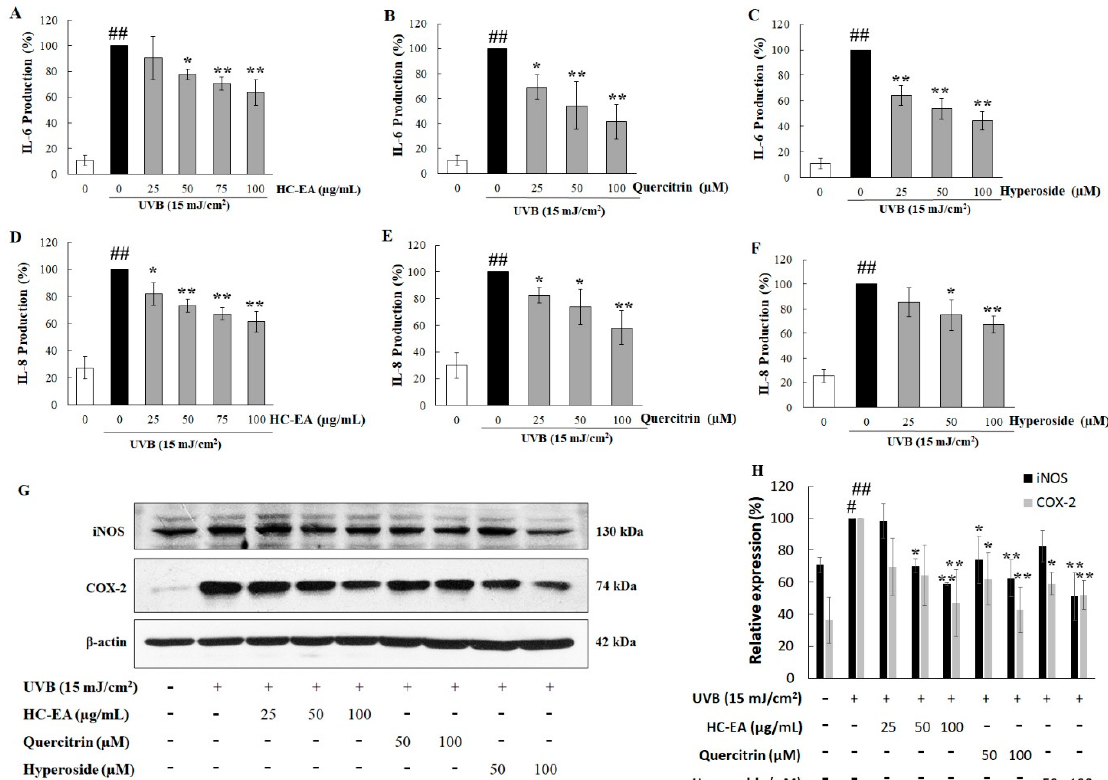
Figure 4. Anti ‐ inflammatory effects of HC ‐ EA and its active compounds on UVB ‐ irradiated HaCaT cells. The cells were treated with various concentrations of HC ‐ EA, quercitrin, and hyperoside or 4 h before being UVB irradiated; the culture supernatants were collected at 24 h after UVB exposure and the effects of HC ‐ EA ( A ), quercitrin ( B ), and hyperoside ( C ) were measured on production of IL ‐ 6 ( A – C ) and IL ‐ 8 ( D – F ) using ELISA. Western blotting was performed to evaluate the effects of HC ‐ EA and its bioactive compounds on the UVB ‐ induced expression of proteins involved in inflammation (iNOS and COX-2) at 6 h after UVB irradiation in HaCaT cells ( G ). Densitometric and statistical analysis were performed for relative expression levels of proteins normalized to β‐ actin ( H ). The experiments were repeated at least three times. * p < 0.05, ** p < 0.01, as compared to the UVB ‐ irradiated alone group. # p < 0.05, ## p < 0.01, as compared to the control group. Data are rep ‐ resentative of three independent experiments as mean SD.